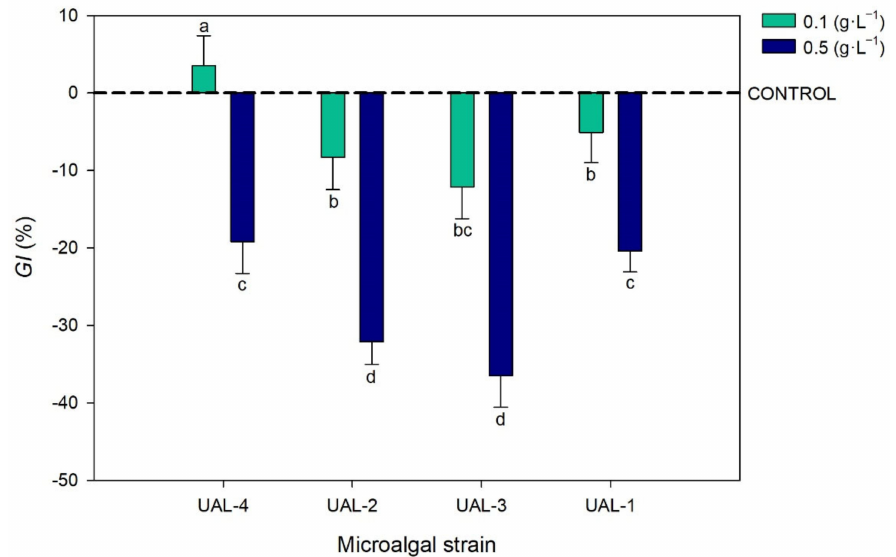
Figure 3. Effect of the microalgal extracts on the germination index of watercress seeds. Values represent the percentage of variation with respect to the control (distilled water). Values represent the mean values ± SD. Different letters indicate significant differences ( p < 0.05).